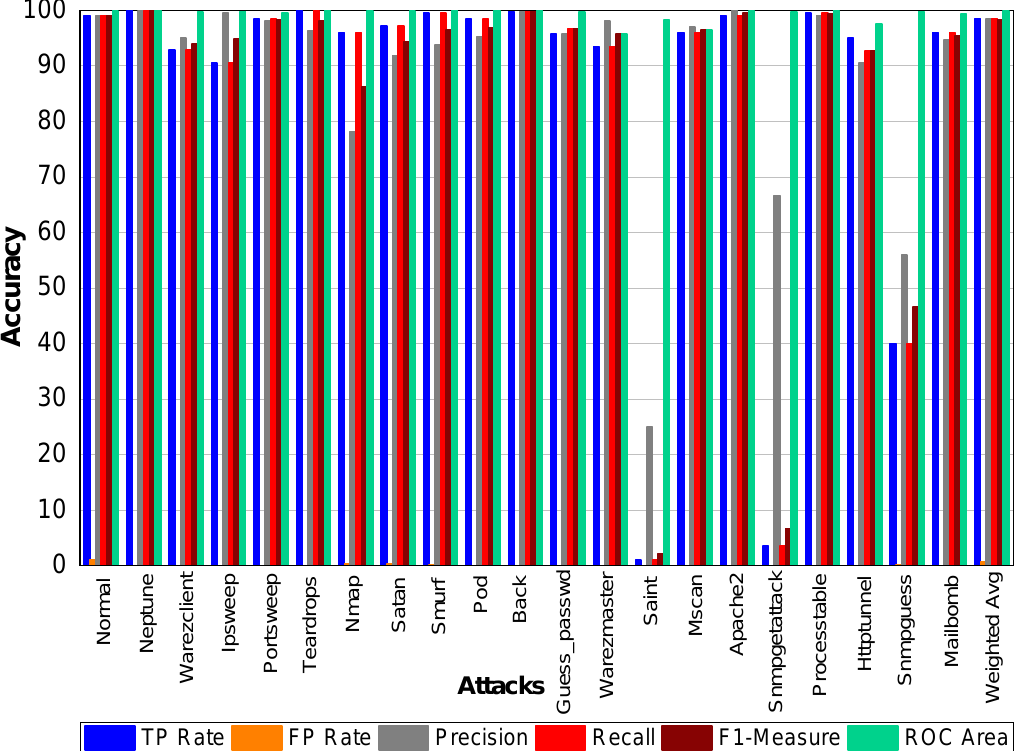
Figure 12. Classification report for the Bagging J48 NSLKDD